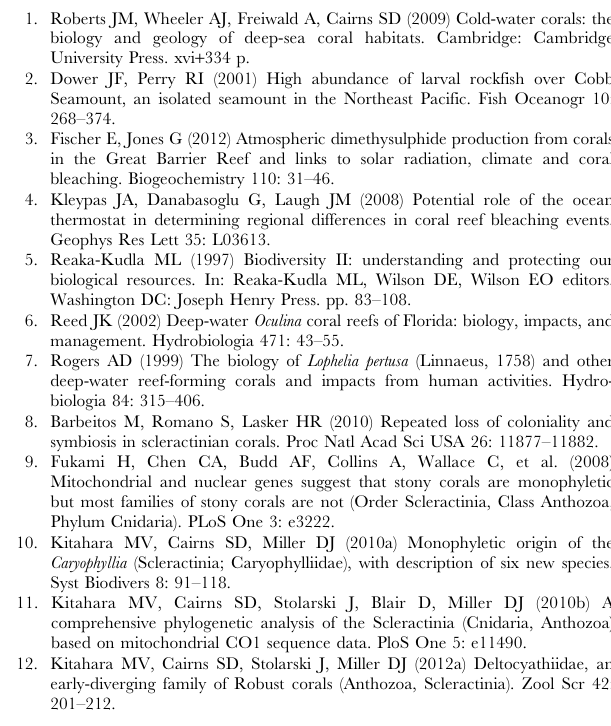
Figure S3 Phylogenetic analyses based on the nucleo- tide sequences of the mitochondrial genes encoding proteins re-coded as purines and pyrimidies (RY-coding see [44,45] ) with the exclusion of the third codon position from the resulting alignment. Values on the nodes indicate the posterior probability (BI) support. Where no values are shown on a node, that edge was fully supported under all analyses. Figure S4 Graphical representation of (G + C)- (red line) and (A + T)- (blue line) skew calculated on the whole mitochondrial genome of all species included in the present analysis. The (A + T)-skew is . 6% higher in ‘‘Robust’’ corals than in all other hexacorallians included in the present analyses (highlighted in yellow). Figure S5 Minimum evolution tree on BF distances from the complete mt protein coding DNA sequences. Topologies are based on nucleotide BF distances (left topology) and aa BF distances (right topology). AA compositional bias slightly favors the ‘‘naked coral’’ hypothesis (yellow box) whereas nt based BF topology appears to be more homogeneous. Figure S6 Empirical distribution of the difference between the likelihood of the fitted model and the best possible likelihood (the product of column pattern frequencies). In each case the arrow indicates the observed value of that difference. The distributions are shown for the nucleotide alignment of the protein coding sequences with the GTR model (A) and the Barry and Hartigan model (B), for the